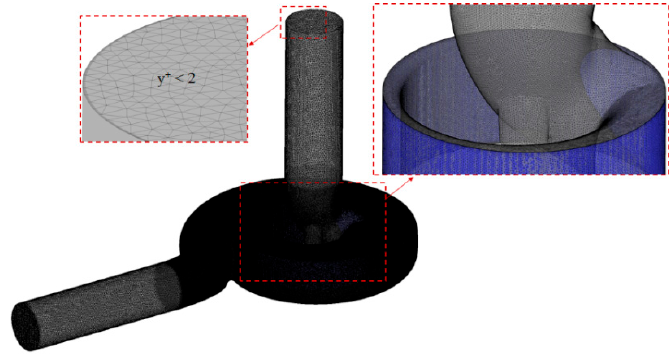
Figure 3. Grid systems of computational domain.